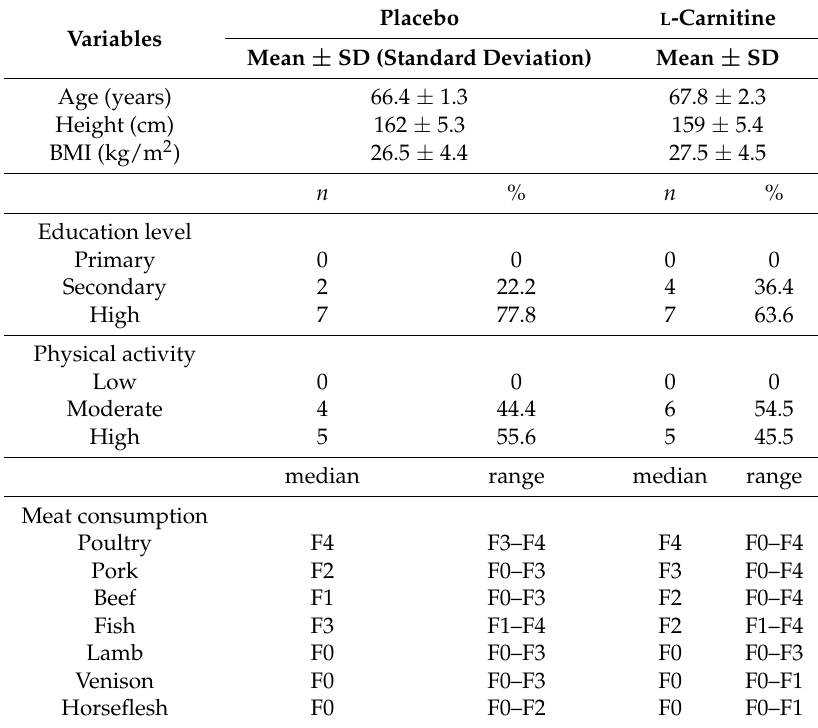
Table 1. Basic characteristics of the